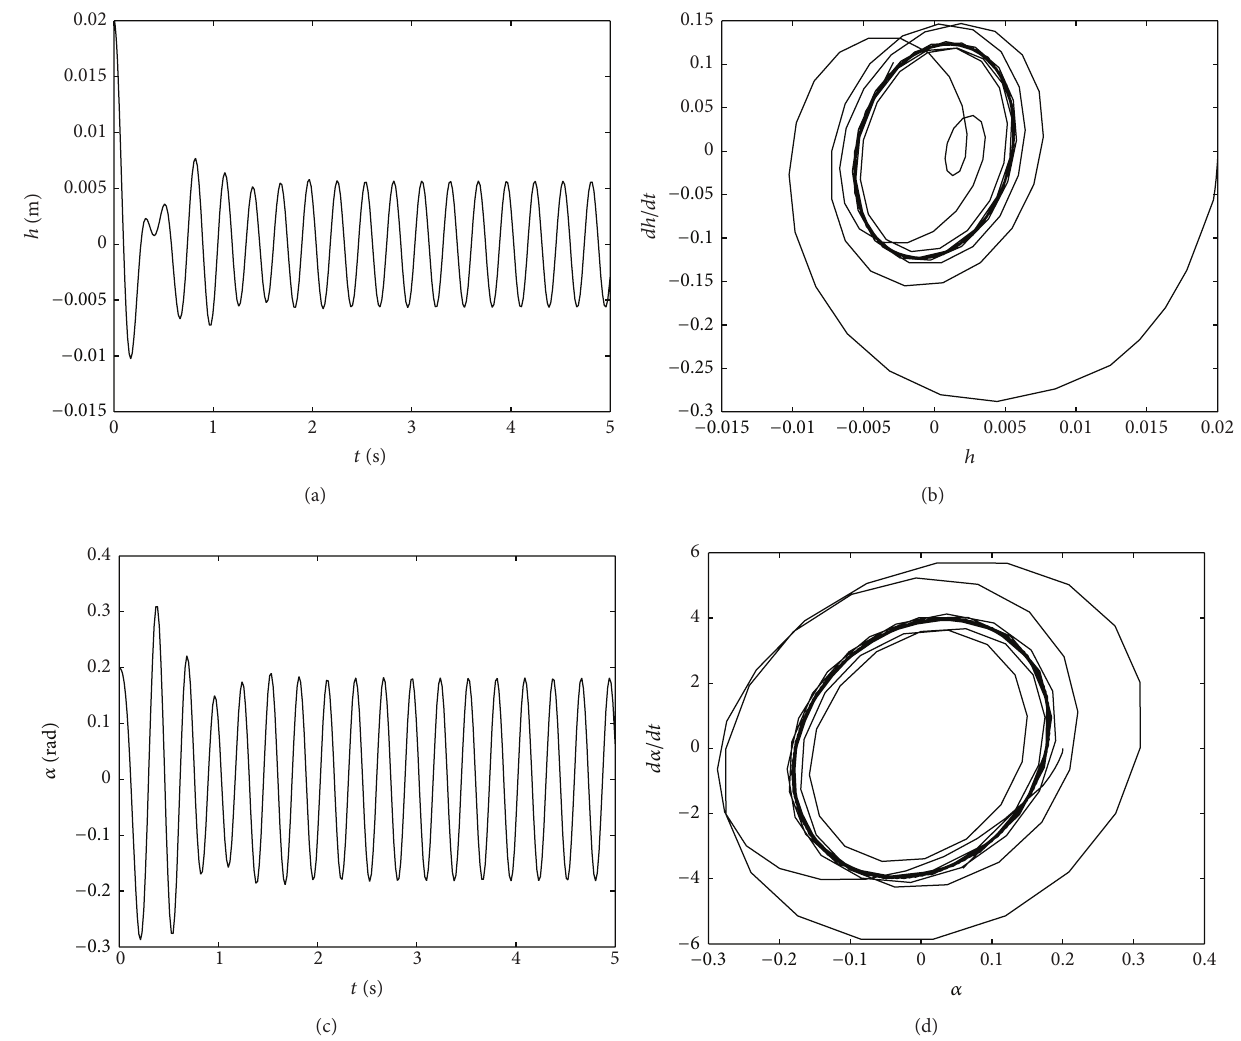
̇ℎ . (c) Pitch. (d) Phase plane plot 𝛼 − ̇𝛼 .